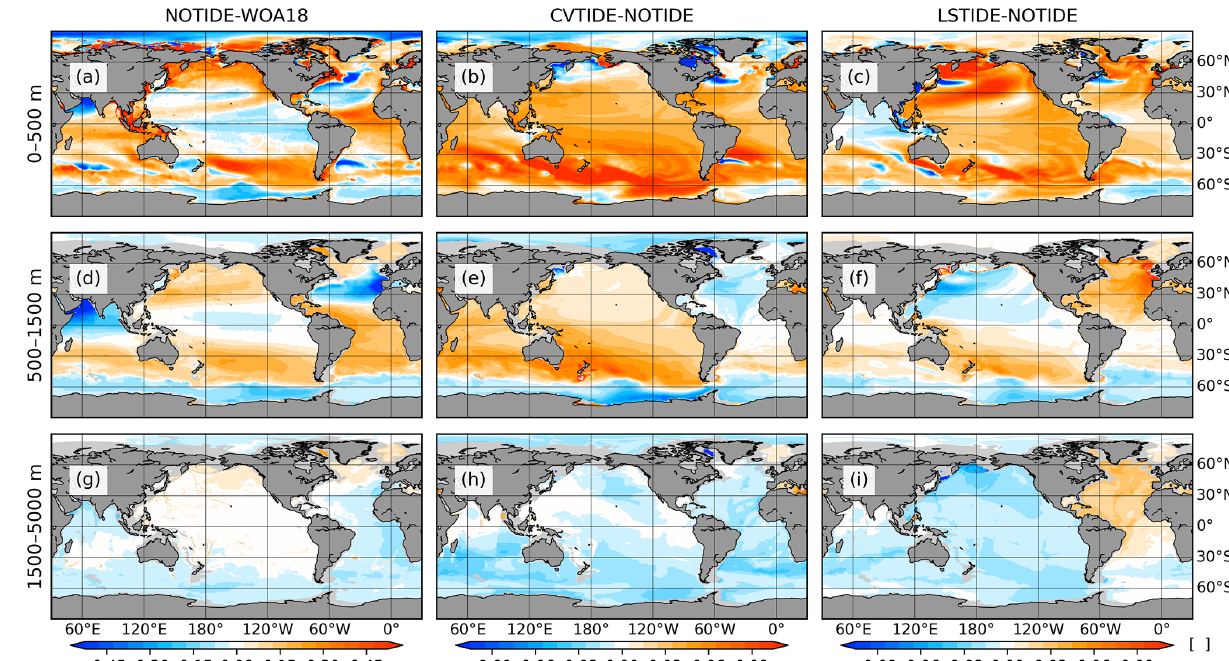
Figure 2. The same as Fig. 1 but for salinity.